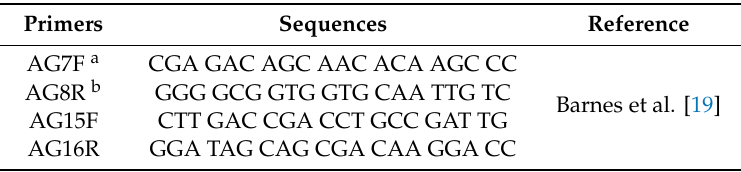
Table 2. Microsatellite primers used in this